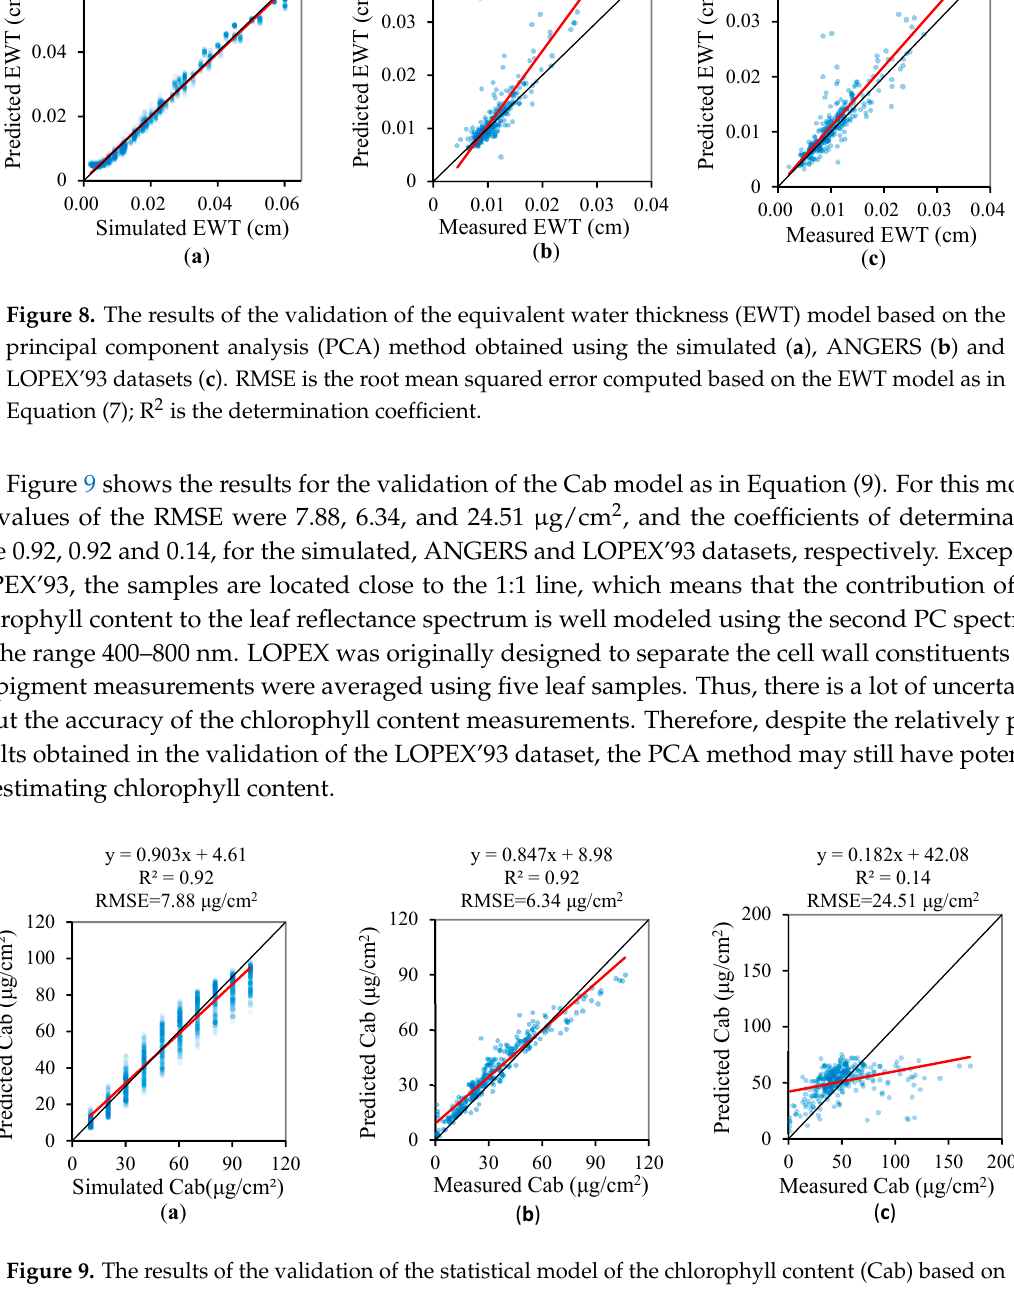
content to the leaf reflectance spectrum is not well modeled by the PCA method.